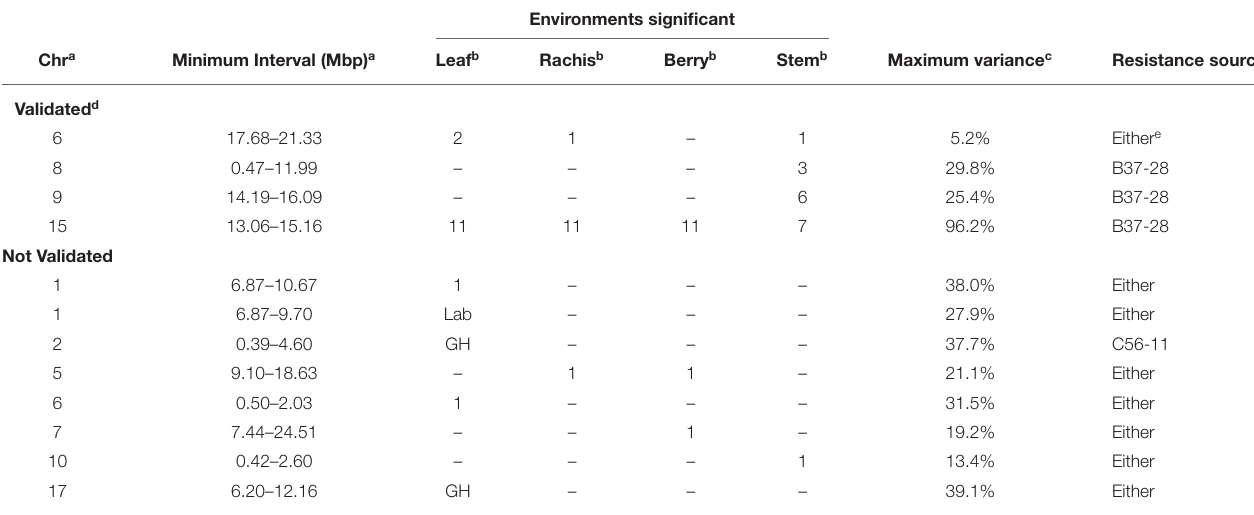
TABLE 1 | The number of vineyard environments, greenhouse (GH) timepoints, and laboratory (Lab) experiments with significant quantitative trait locus (QTL) for powdery mildew severity by tissue in B37-28 ×